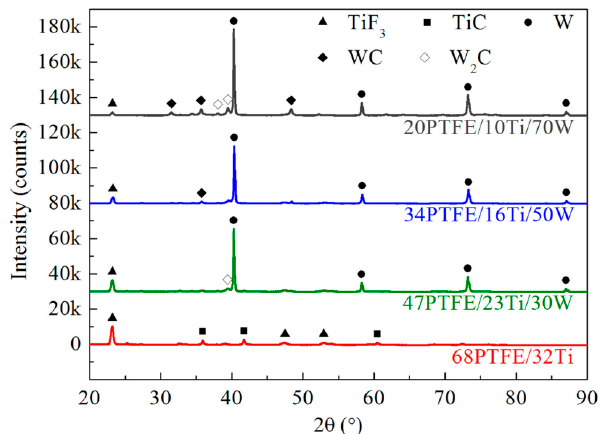
Figure 5. XRD results of solid reaction products of PTFE/Ti/W composites after DSC tests.